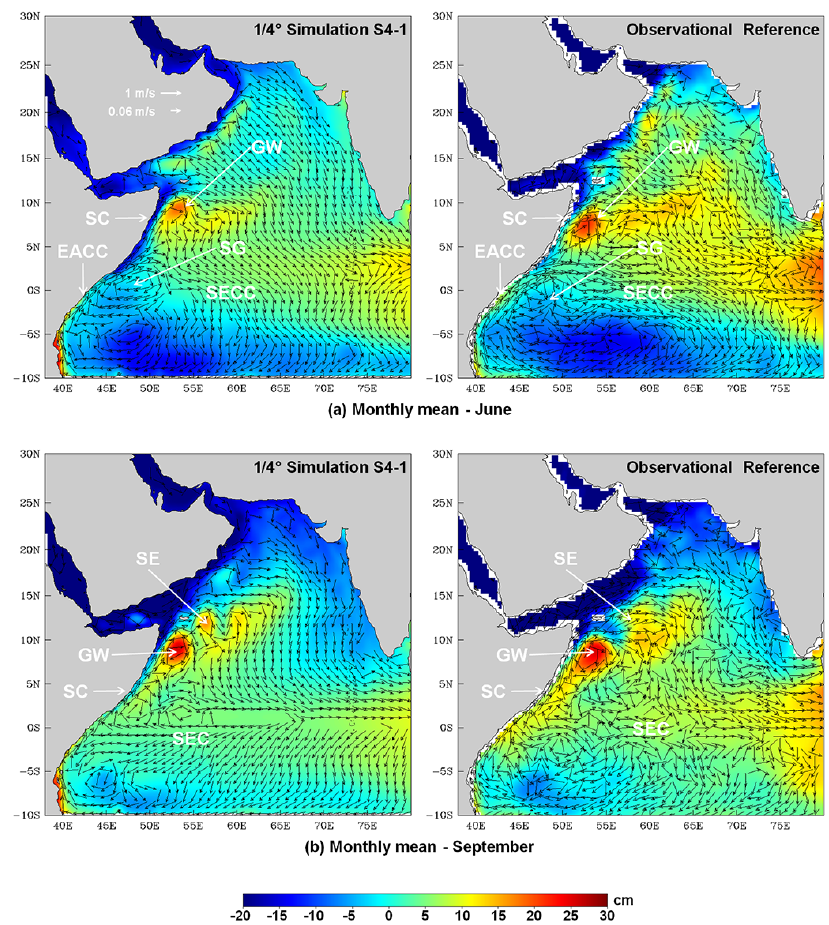
Figure 1. Climatological mean of the sea surface height (colour shading; cm) with currents at 15m depth superimposed (vectors; ms − 1 ) in the 1 / 4 ◦ S4-1 simulation and in the observational reference for: (a) the month of June and (b) the month of September. The model climatological mean is calculated over the last 10 years of the simulation. Currents smaller than 0.05ms − 1 are not plotted. SC is Somali Current. EACC is East African Coastal Current. SEC is South Equatorial Current. SECC is South Equatorial Counter Current. GW is Great Whirl. SG is Southern Gyre. SE is Socotra